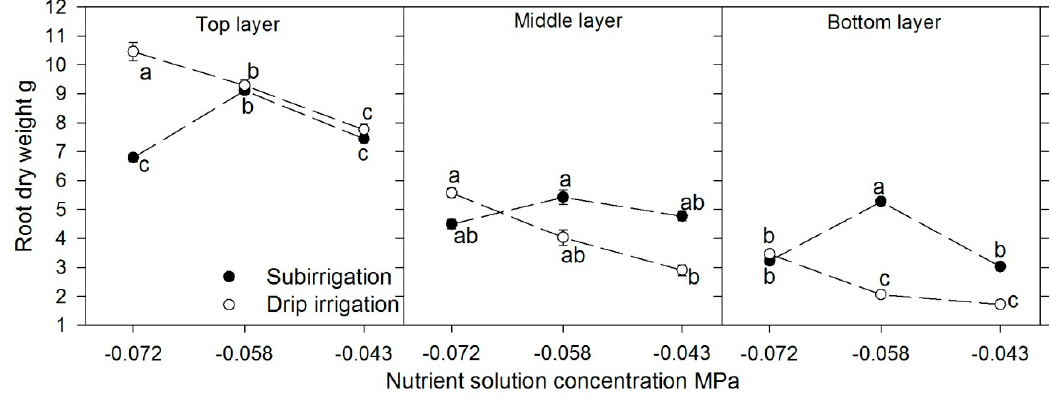
Figure 1. Root dry weight of tomato ( Solanum lycopersicum L.) plants as a ff ected by irrigation method (IM, p = 0.127), nutrient solution concentration (NSC, p ≤ 0.001), substrate layers (SL, p ≤ 0.001) and the interactions between factors (IM × NSC, p ≤ 0.001; IM × SL, p ≤ 0.001; NSC × SL, p = 0.449; IM × NSC × SL, p = 0.122) at the termination of the experiment. Means with the same small case indicate non-significant di ff erences according to Tukey’s multiple comparison test. Bars represent the standard error of the mean (n = 4).